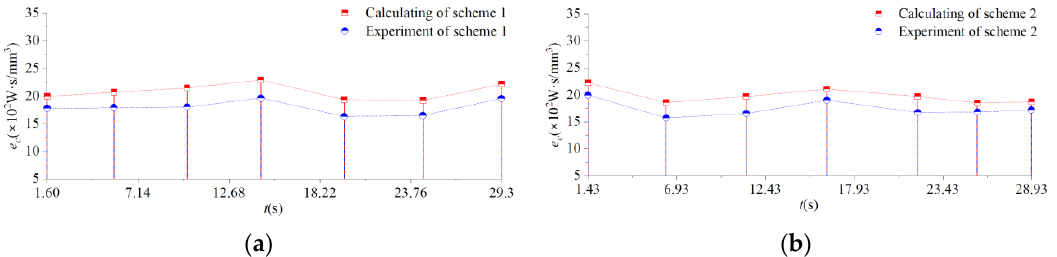
Figure 26. The solved and measured results of specific tangential-force energy of milling cutter. ( a ) scheme 1; ( b ) scheme